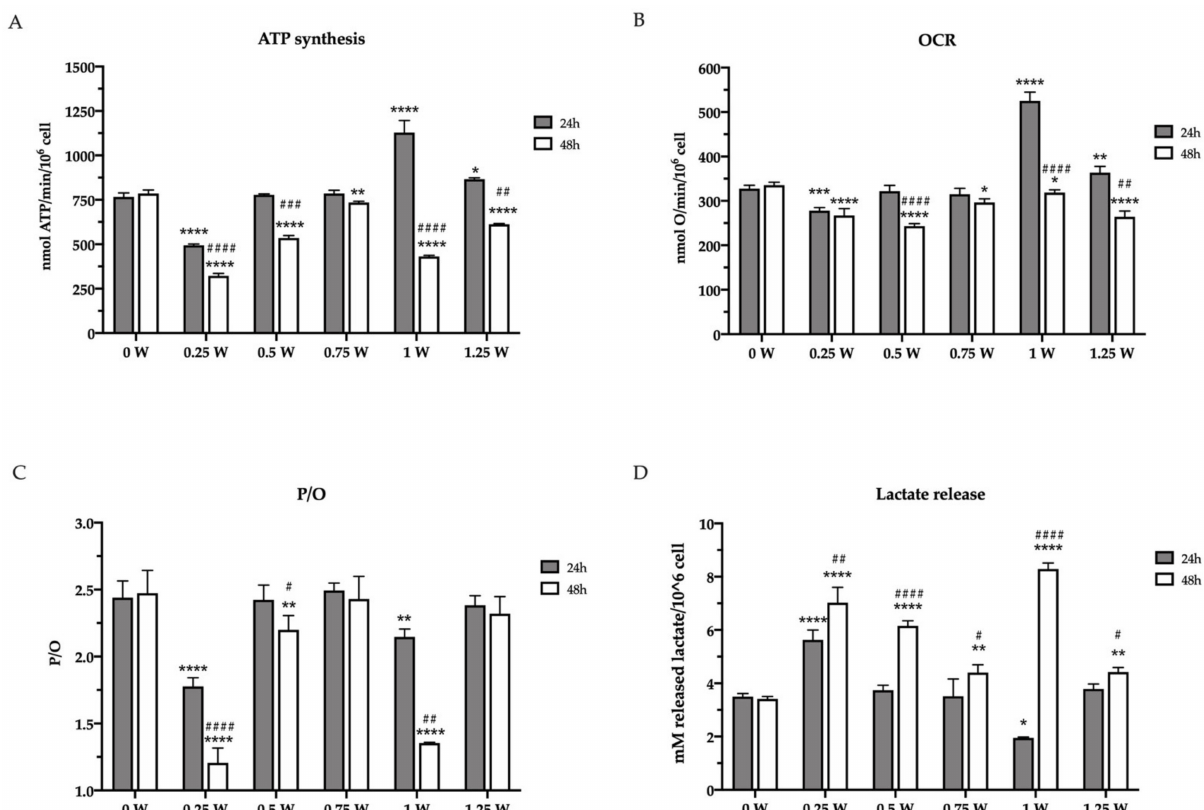
Figure 3. Glucose metabolism modulation in OHSU-974 FAcorr cells after 808-nm laser irradiation. ( A ) ATP synthesis through FoF1-ATP synthase; ( B ) the oxygen consumption rate (OCR). For both graphs, data are obtained in the presence of pyruvate plus malate as respiring substrates. ( C ) P/O value, calculated as the ratio between the synthesized ATP and the consumed oxygen. ( D ) Lactate release in the growth medium. In each graph, grey and white columns represent the data obtained 24 or 48 h after the laser irradiation, respectively. Data are reported as mean ± SD, and each graph is representative of at least three independent experiments. Statistical significance was tested by a two-way ANOVA. *, **, ***, and **** represent p < 0.05, 0.01, 0.001, and 0.0001, respectively, between the treated sample and the untreated sample (0 W) used as control, at the same time after irradiation. #, ##, ###, and #### represent p < 0.05, 0.01, 0.001, and 0.0001, respectively, between the values obtained after 24 h and 48 h from the laser irradiation in the sample treated with the same laser